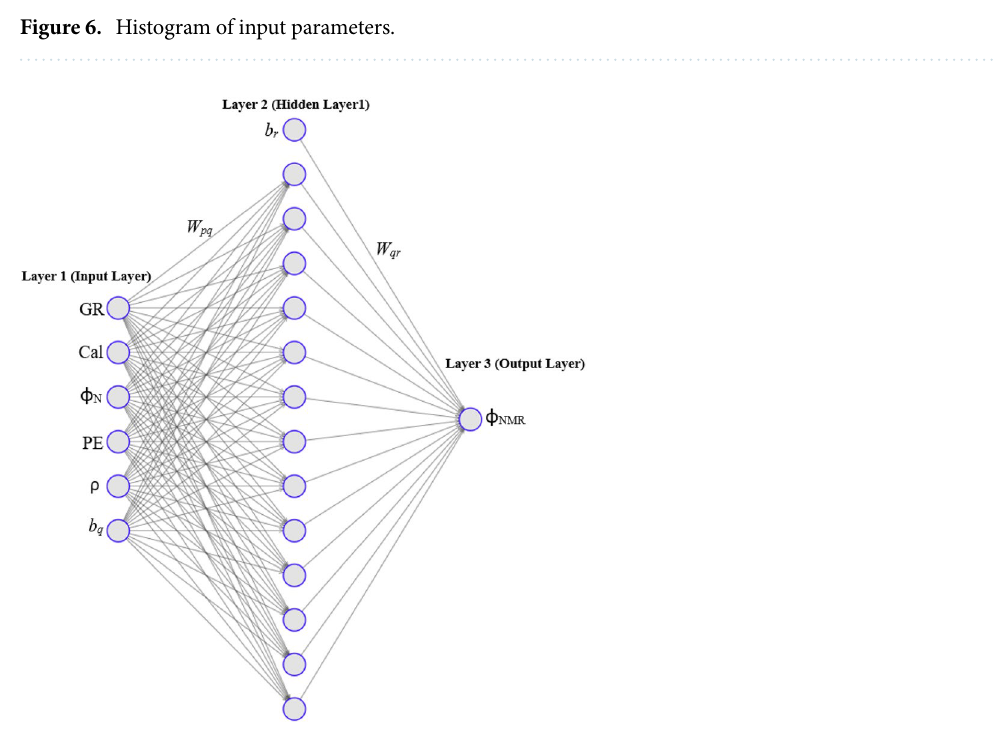
Figure 7. Neuron structure showing the ANN model